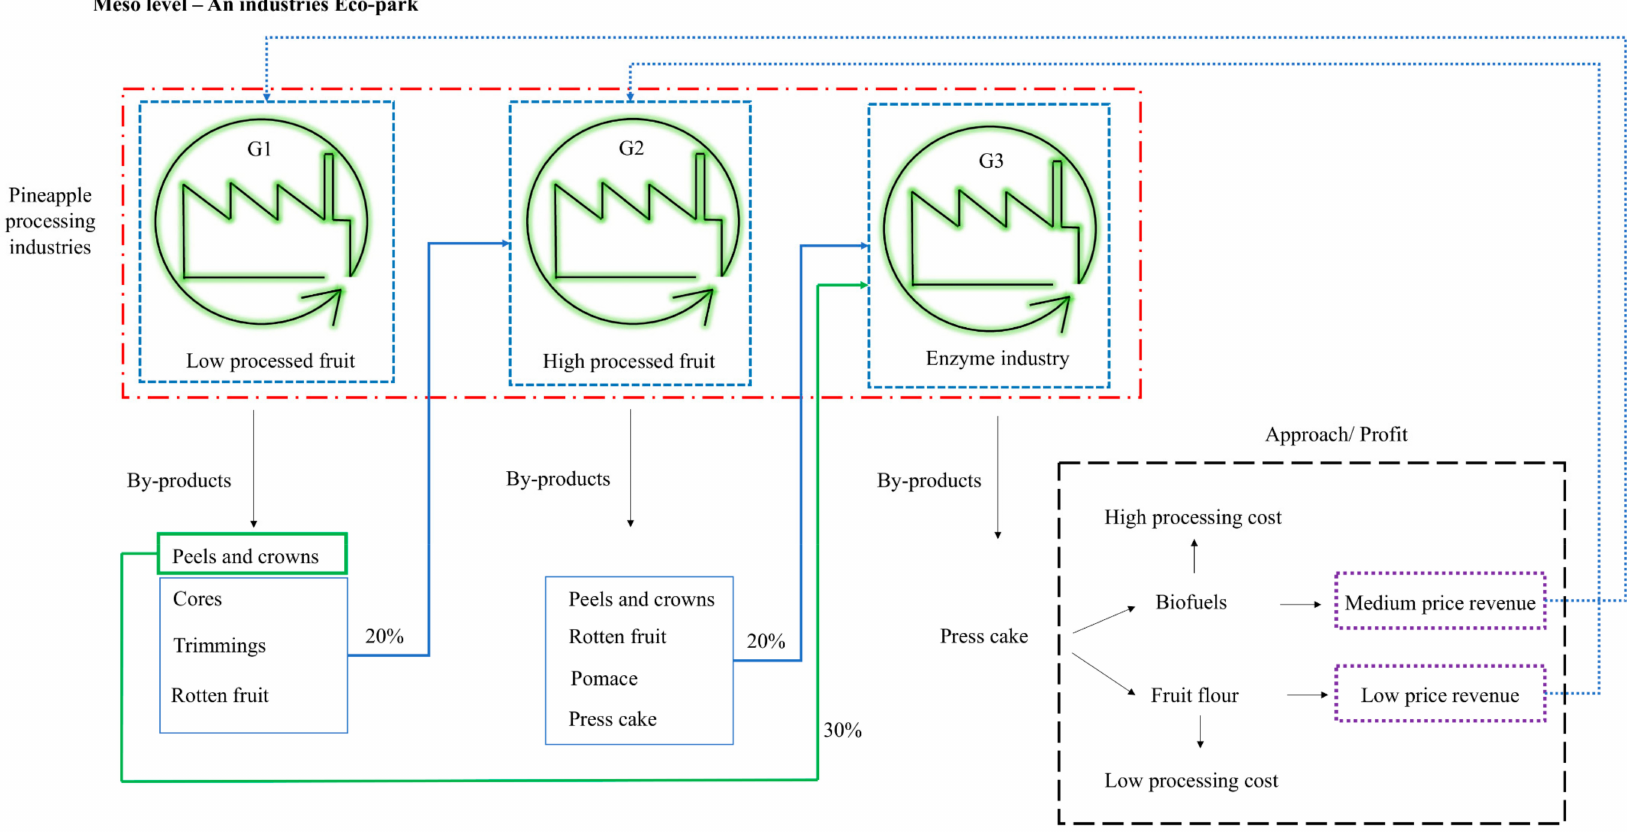
Figure 2. Implementation of circular economy at a meso level for pineapple processing